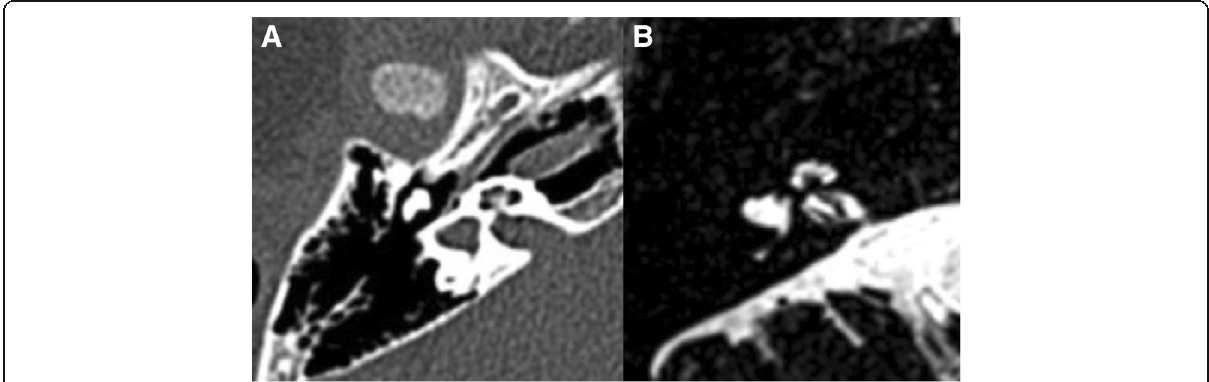
Fig. 7 Temporal bone CT ( a ) and MRI (axial T2/3D) ( b ) from a 2-year-old patient with Down syndrome at the level of the internal auditory canal, showing complete absence of the right bone island and consequent aplasia of the lateral semi-circular canal. Note also the dysplastic vestibule as a result of the absence of the lateral semi-circular canal